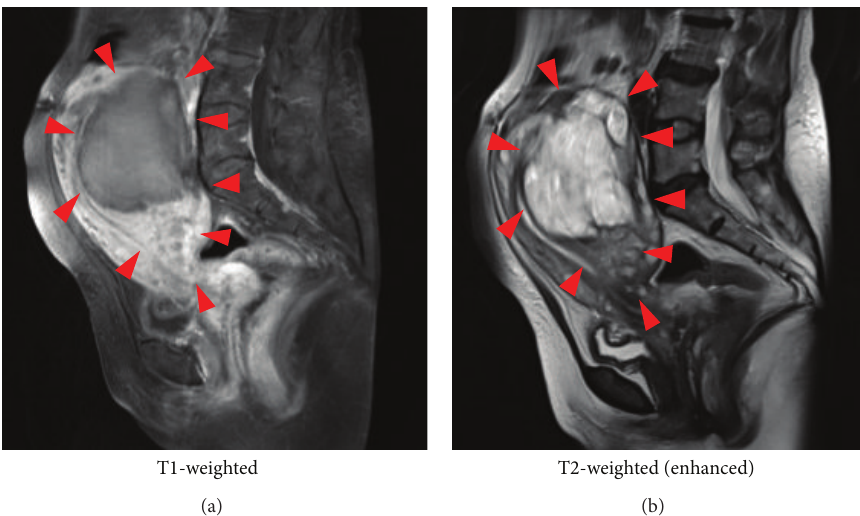
Figure 1: Frontal pelvic magnetic resonance imaging demonstrated a lobular tumor with low T1- and high T2-signal intensity on the posterior wall of the